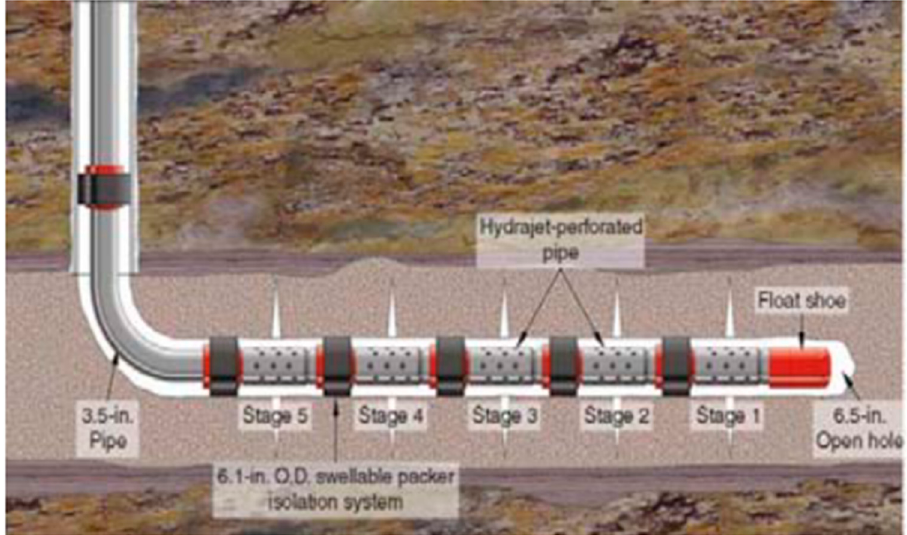
Figure 18. Hydra-jet perforation system.